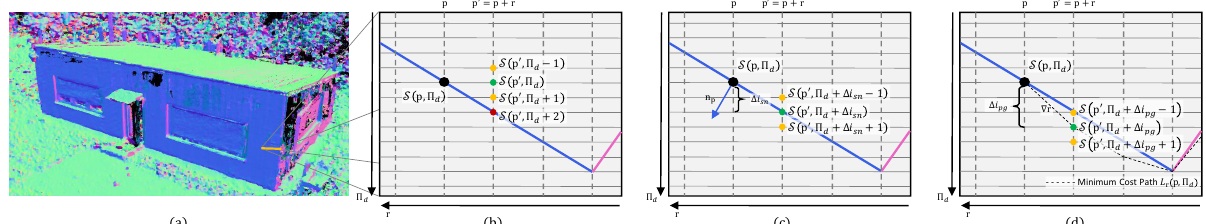
Figure 2. Illustration of the SGM x path aggregation along one path direction r . (a) Normal map of a building. The yellow line indicates the area for which the SGM x path aggregation is shown. (b) Illustration of the SGM fp path aggregation. The blue and pink lines correspond to blue and pink surface orientations on the building facade. When aggregating the path costs for pixel p at plane Π d , SGM fp will incorporate the previous costs at the same plane position (green) without additional penalty. The previous path costs at Π d ± 1 (yellow) will be penalized with P 1 . The previous path costs located at Π d + 2 (red), which is actually located on the corresponding surface, will be penalized with the highest penalty P 2 . (c) SGM sn uses the normal vector n p , encoding the surface orientation at pixel p , and computes a discrete index jump ∆ i sn , which adjusts the zero cost transition, causing the previous path costs at Π d + 2 to not be penalized. (d) Similar to SGM sn , SGM pg adjusts the zero cost transition. However, the discrete index jump ∆ i pg is derived from the running gradient ∇ r of the minimum cost path. As illustrated, however, this can overcompensate the shift of the zero cost transition.